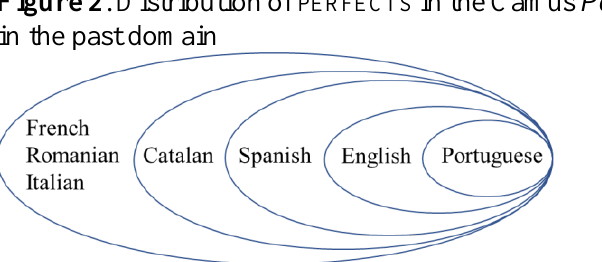
Figure 2 . Distribution of PERFECTS in the Camus Passé Composé corpus: a subset relation in the past